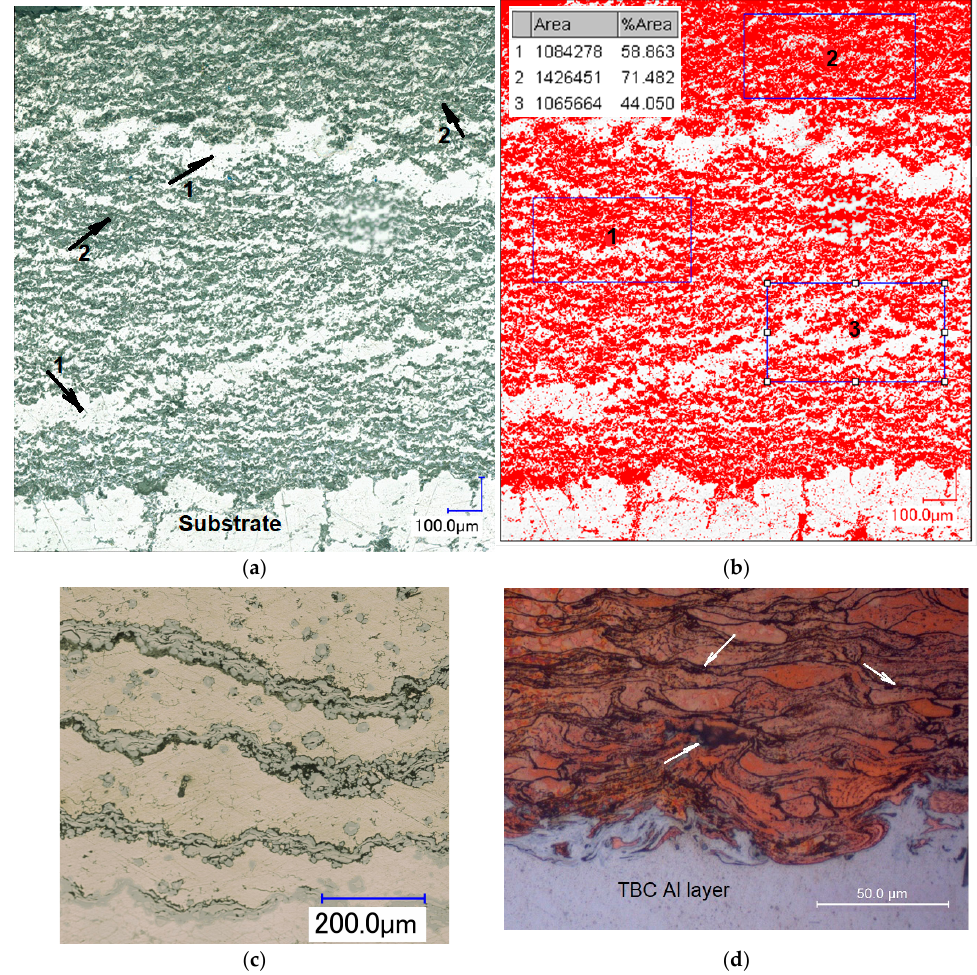
Figure 1. Optical microscopy structure of the coatings. ( a ) two-phase Al-ZrO 2 homogenous structure; ( b ) same as ( a ) with the ZrO 2 area in red; ( c ) AISI304-(Al + ZrO 2 ) three-phase layered coatings; ( d ) Cu-Graphene catalytic layer deposited on the multi-layer TBC. Some of the graphene aggregates are shown by white arrows.